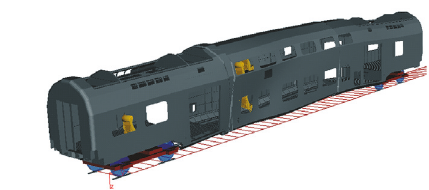
Figure 11: Connection of the flexible coach to the bolsters.